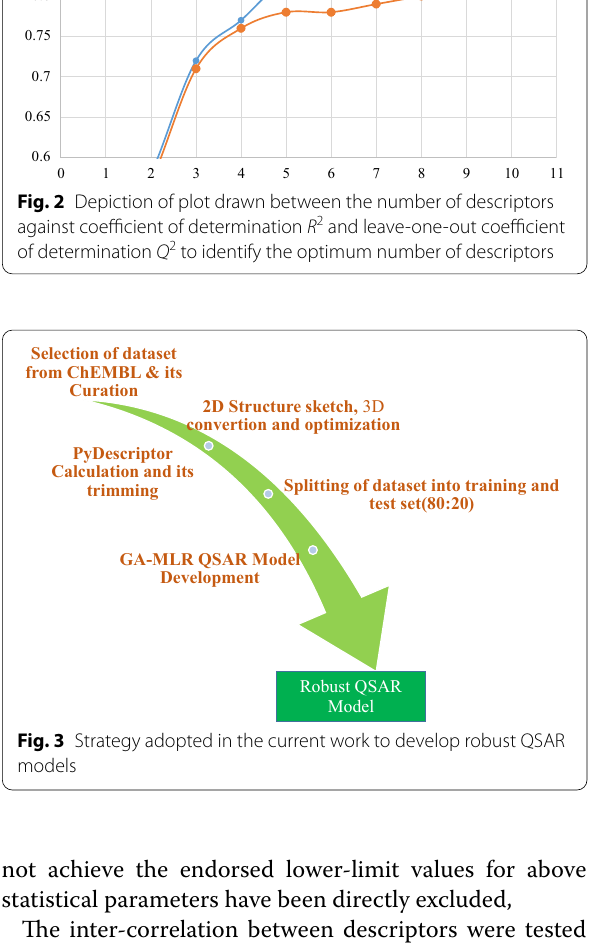
Fig. 3 Strategy adopted in the current work to develop robust QSAR